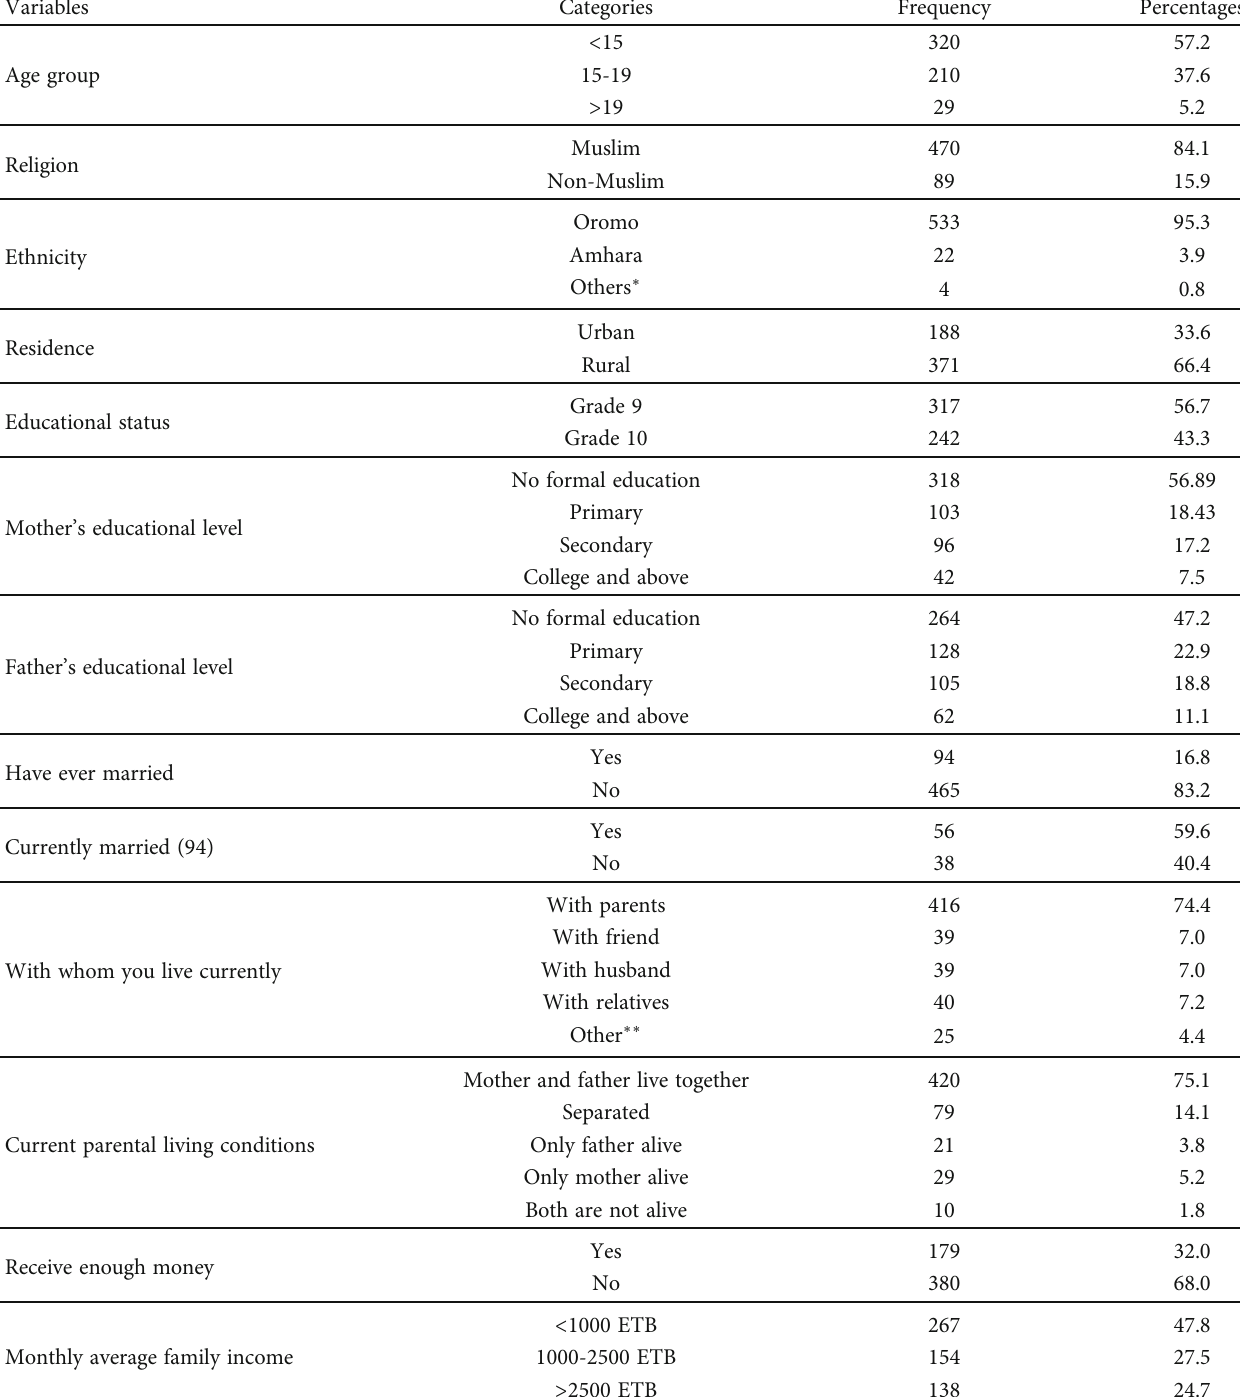
Table 1: Sociodemographic characteristics of high school female students in Jarso district, Oromia region, eastern Ethiopia, 2019 ( n = 559